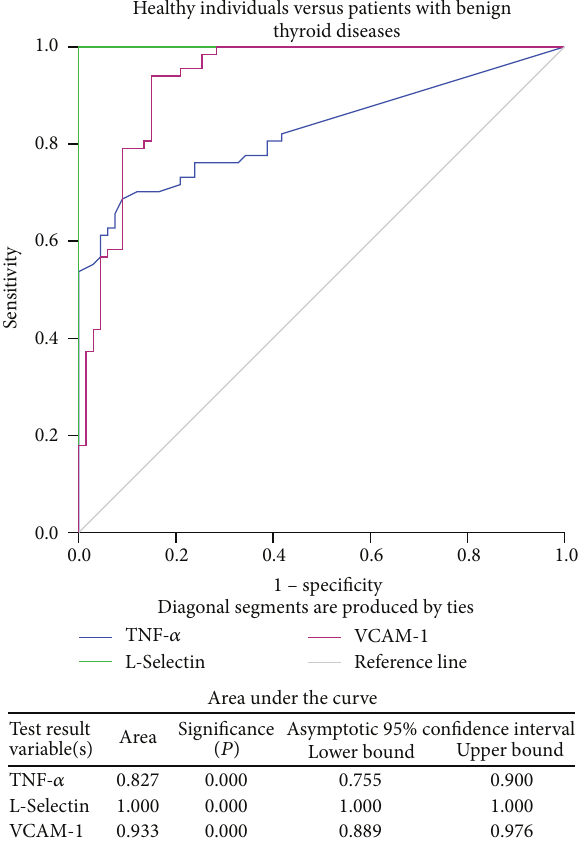
Figure2:ROCcurveforTNF- 𝛼 ,L-Selectin,andVCAM-1inhealthy individuals versus PTC